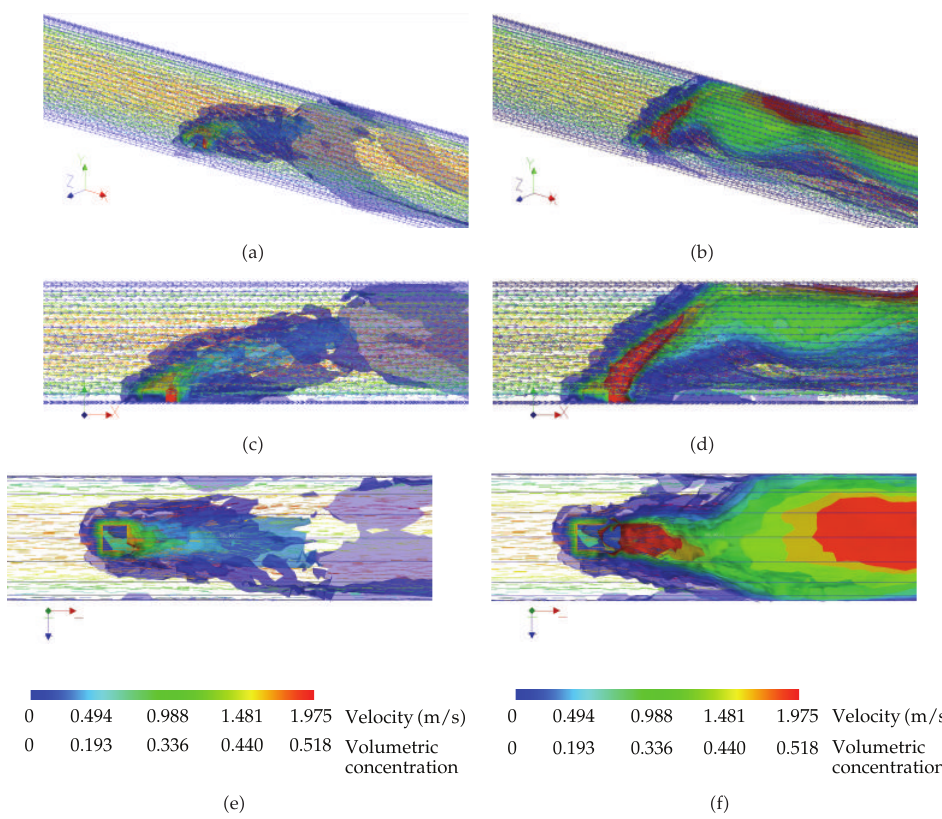
Figure 6: Model 1: combined velocity vector and concentration isosurface plots for wind speeds 1.23 (cid:2) a, c, e (cid:3) and 1.235ms − 1 (cid:2) b, d, f (cid:3) at 100s elapsed time. The colour plot applies to all 6 figures. (cid:2) a, b (cid:3) Orthogonal view. (cid:2) c, d (cid:3) Side view. (cid:2) e, f (cid:3) Top (cid:2) plan (cid:3) view.